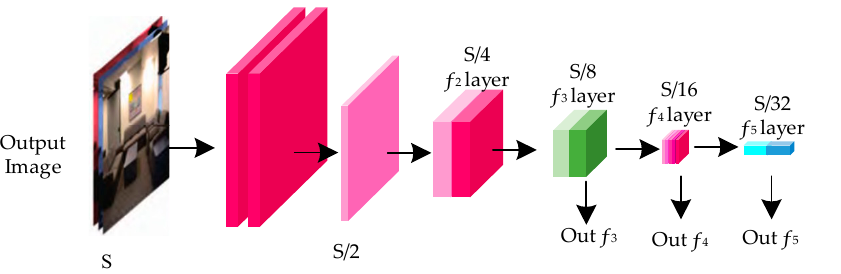
Figure 3. Encoder network.